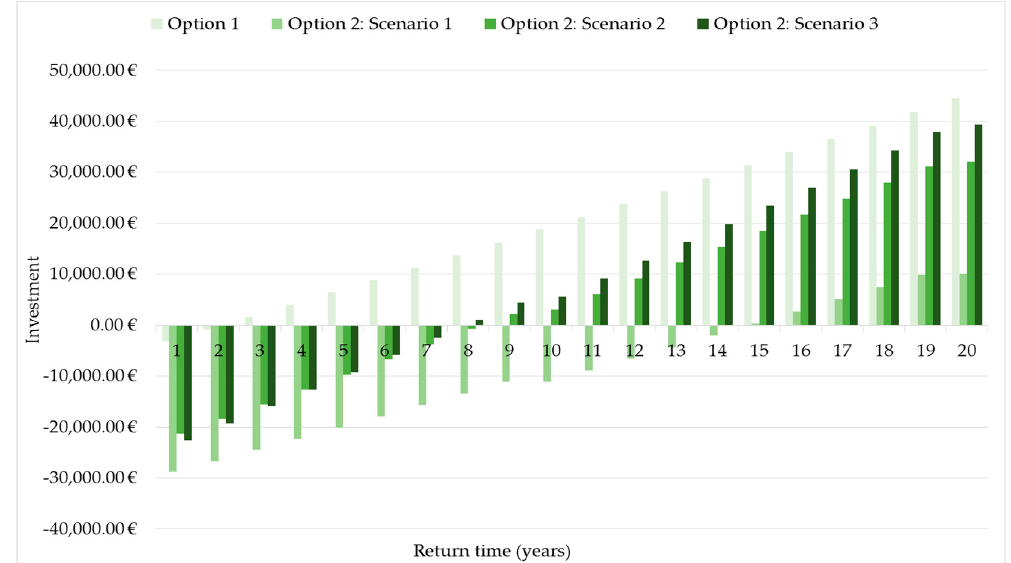
Figure 2. Return time of the